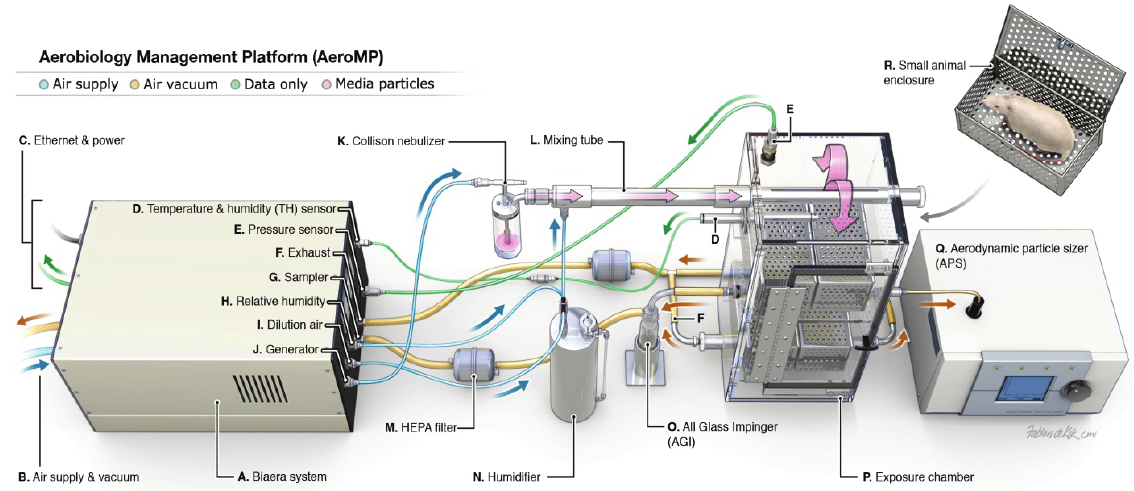
Figure 8. Schematic presentation of the Automated Aerosol Management Platform. The AAMP is fully contained within the Class III BSC. Compressed air under negative pressure enters the aerosol unit, which is controlled by mass flow controllers and experimental parameters dictated by the researcher on a laptop (not shown). Droplets produced by aerosol generation pass through a mixing tube, are diluted with additional air, and dried. This conditioning of particles ensures that the particles are monodispersed prior to entry into the whole body chamber. Simultaneously, the vacuum pulls air through the whole body chamber ensuring that newly generated particles pass through the chamber while maintaining a dynamic system. A biosampler or cascade impactor and particle sizer are attached to the whole body chamber for collection and analysis. The overall flow of the system is shown by the directional